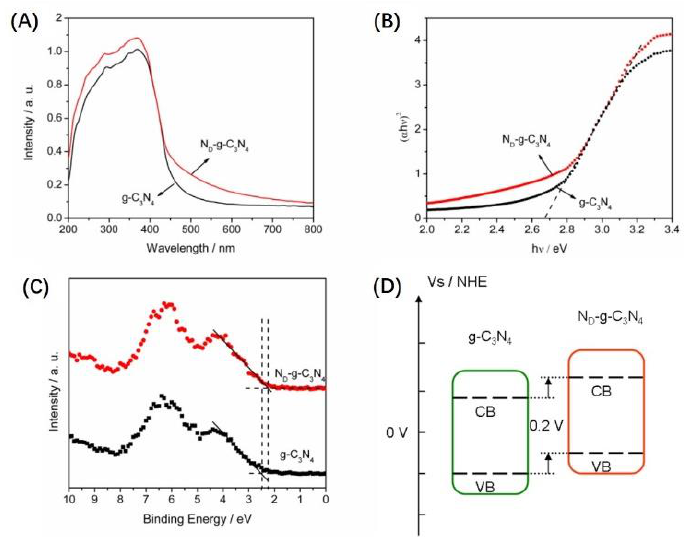
Figure 6. ( A ) UV-Vis DRS, ( B ) Tauc model to estimate bandgap, ( C ) VB-XPS and ( D ) electronic band structure of the samples.